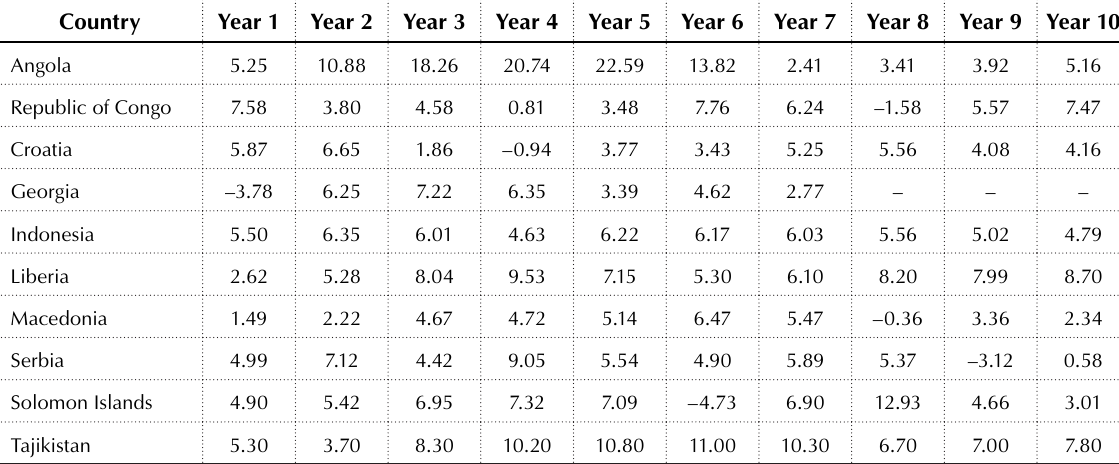
Table 6. GDP growth, annual %